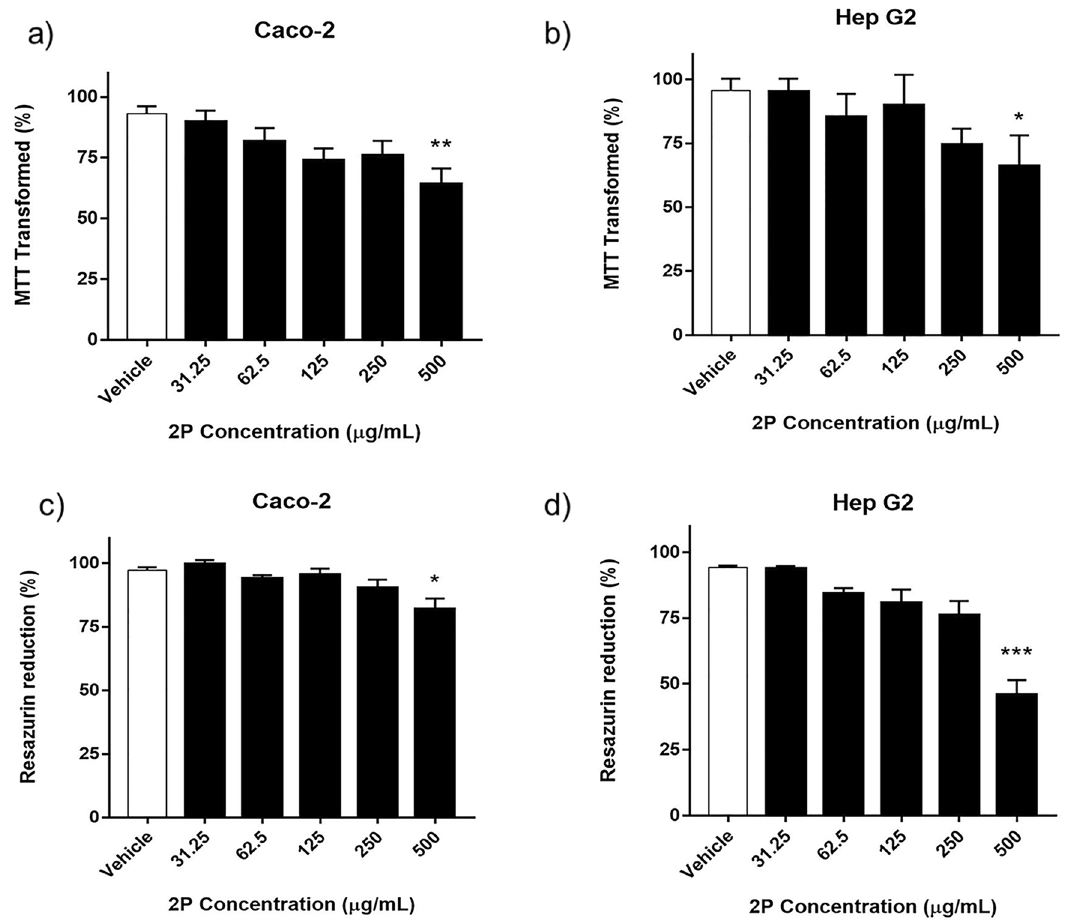
Figure 5. Evaluation of cytotoxicity induced by the 2P nitrogen-based compound. Cytotoxicity was determined by either the percentage of ( a , b ) MTT transformed or ( c , d ) Resazurin reduction detected in the HepG2 and Caco-2 cells exposed to concentrations from 500 to 31.25 µg/mL of the 2P derivative in MTT and Resazurin assays. The 2P compound reduced cell viability in a concentration-dependent manner, with no